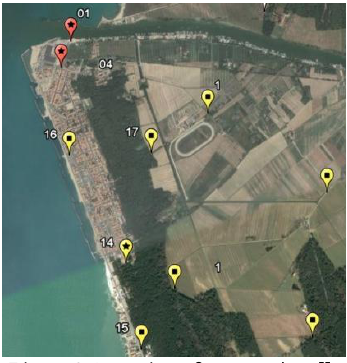
Figure 6. Location of surveyed wells